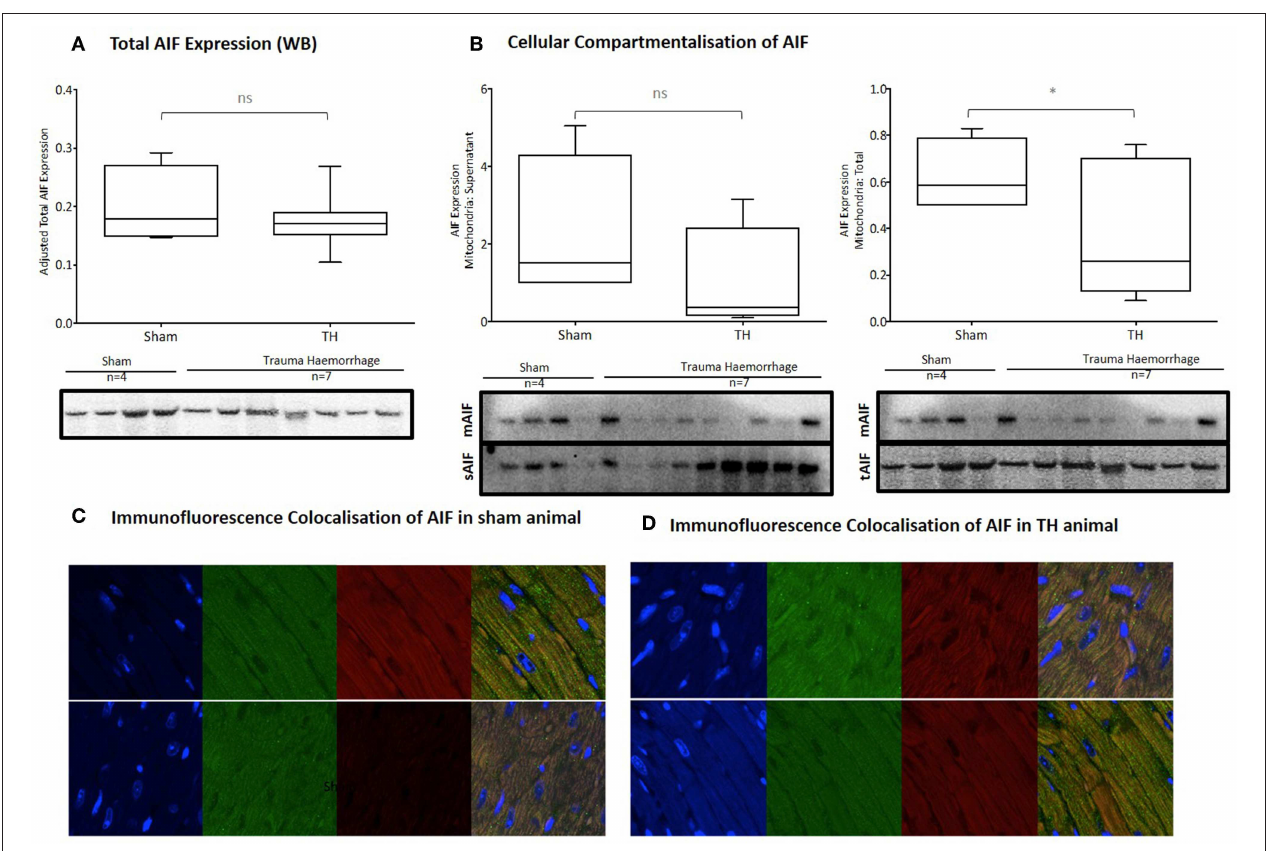
FIGURE 5 | AIF localization in the trauma hemorrhage induced CD murine model. (A) AIF expression as demonstrated by western blot analysis. The total AIF expression is similar in the Sham and THS models (0.20 vs. 0.17, respectively). (B) Cellular compartmentalization of AIF as demonstrated by WB analysis. A higher proportion of AIF is found outside the mitochondria in the THS models. The mean ratio of mitochondrial AIF (mAIF) to supernatant AIF (sAIF) is 1.5 in sham compared to 0.4 in THS group, p = 0.16. When comparing total AIF which includes the nucleus, a lower proportion is still found in the mitochondria. Ratio of mitochondrial AIF (mAIF) to total AIF (tAIF) in sham group is 0.6 compared to 0.3 in THS animals, * p = 0.04. This is suggestive of its translocation of the AIF out of the mitochondrion, potentially to the nucleus, triggering initiation of cells death. IHC sections from TH animals, DAPI (blue), AIF (green), MTCO2 (red), and combined images. In the combined images, localization of AIF in the nucleus can be seen in the THS (D) which in absent in the sham animals (C)